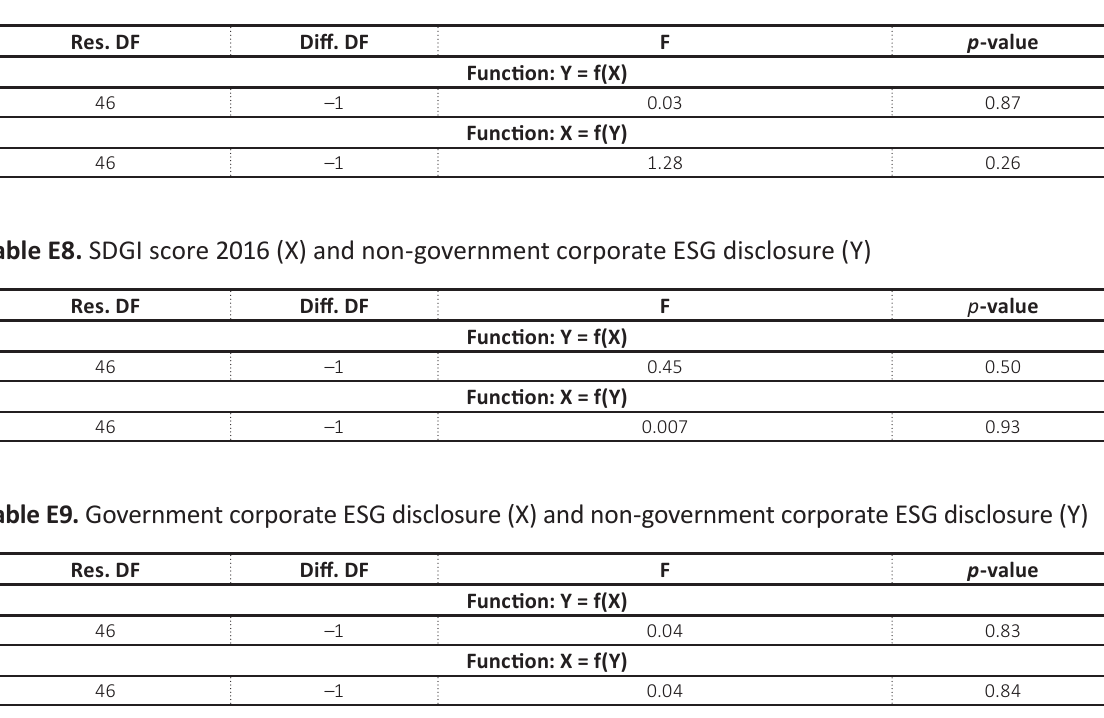
Table E7. SDGI score 2016 (X) and government corporate ESG disclosure (Y)